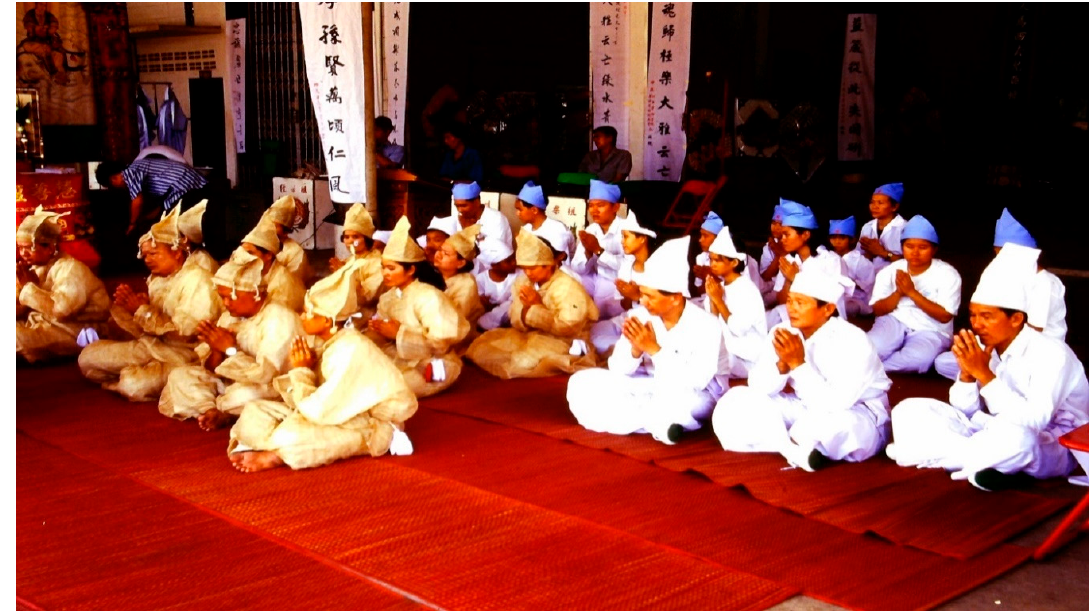
Figure 1. Mourners and the audience in the background. Déji ā o, Khon Kaen, Thailand, 1993 (© B. Formoso).